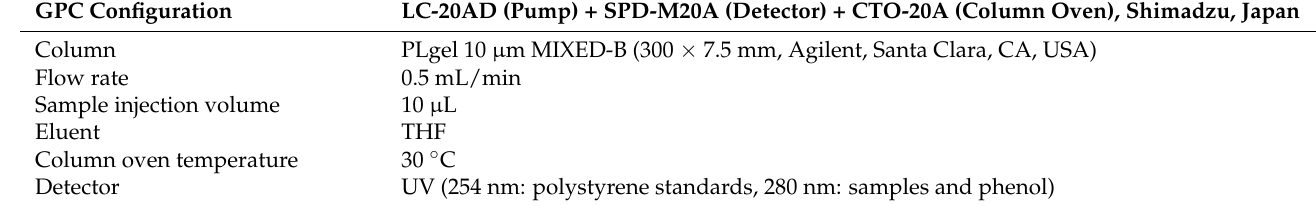
Table 6. Analysis conditions for